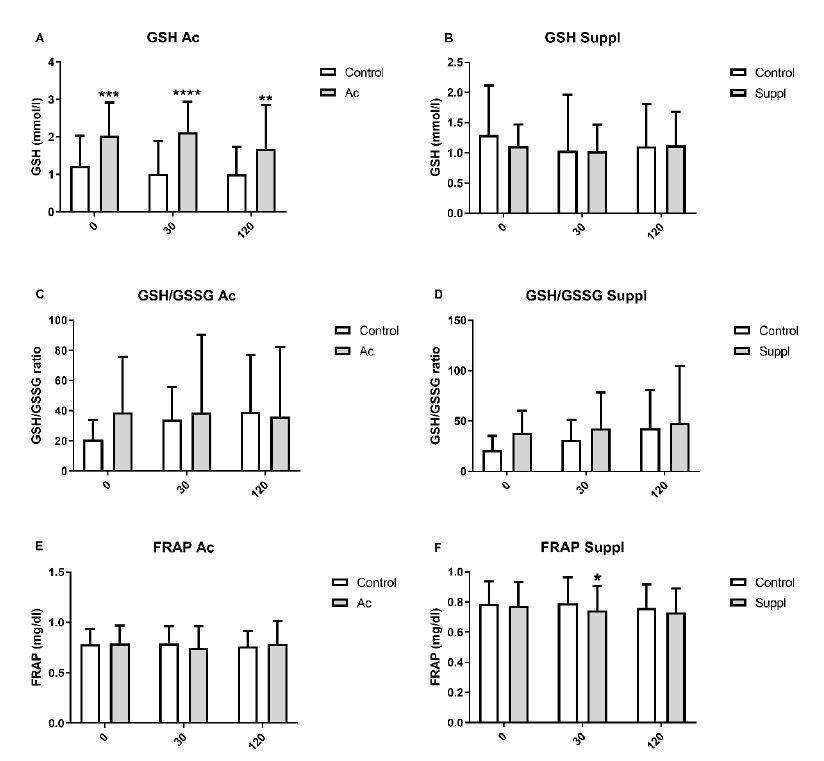
Figure 4. Plasma glutathione levels and antioxidant capacity measured by FRAP assay after acute consumption (Ac) and short-term blueberry supplementation (Suppl) compared to baseline levels (control). ( A ) GSH in acute consumption. ( B ) GSH in short-term supplementation. ( C ) GSH/GSSG in acute consumption. ( D ) GSH/GSSG in short-term supplementation. ( E ) FRAP in acute consumption. ( F ) FRAP in short-term supplementation. Baseline levels are shown by white bars while grey bars represent treatments. * p > 0.05 vs control, ** p < 0.01 vs control, *** p < 0.001 vs. control and **** p < 0.0001 vs. control. GSH: expressed as mM; GSSG: expressed as mM; FRAP: expressed as mg/dl.